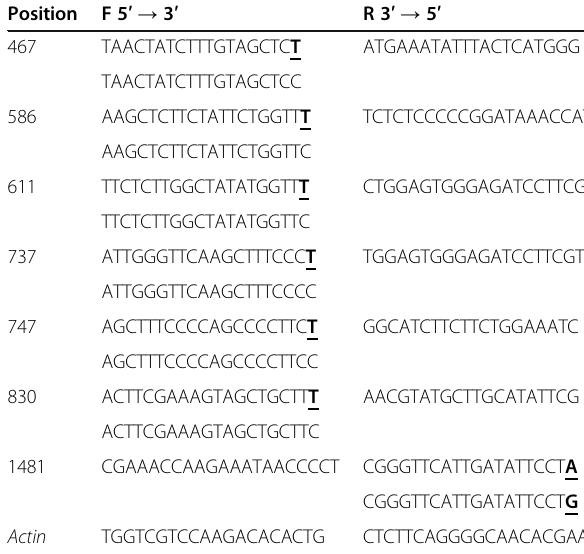
Table 1 Description of forward (5 ′ -3 ′ ) and reverse (3 ′ -5 ′ ) primer sets were designed as two forward specific primers with different 3 ′ ends (original and underlined substitute nucleotide) and one reverse primer site except for position 1481, two specific reverse and one forward